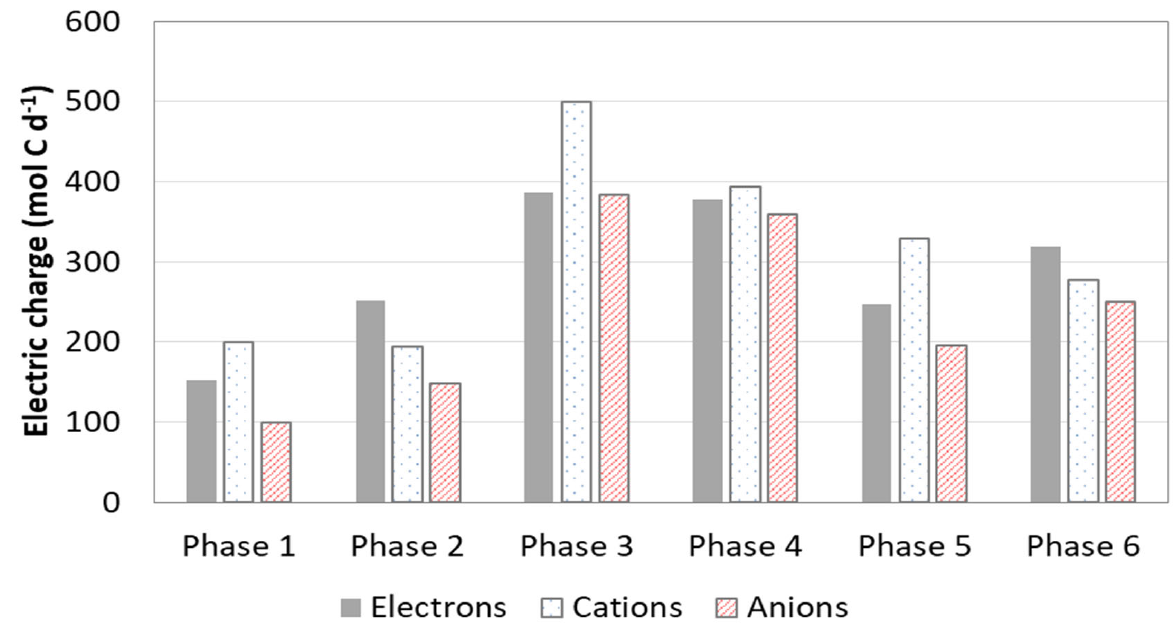
Figure 3. Amount of charge transferred through the electrical circuit (electrons) compared with the charge accumulated in the recovery compartment in the form of anions (C − ) and cations (C + ). Phase 1: not amended feeding was used; Phase 2: catholyte acidified to pH 6; Phase 3; catholyte acidified to pH 5; Phase 4: catholyte acidified to pH 5 and phosphate amended; Phase 5: phosphate amended catholyte; Phase 6: phosphate amended anolyte.